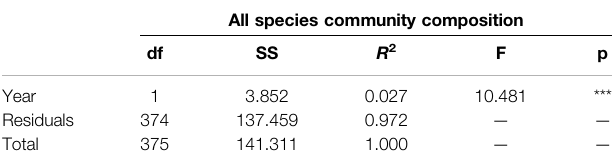
TABLE 2 | Results of permutational multivariate analysis of variance (PERMANOVA) using Bray – Curtis distance matrices, testing for the effect of year on community species composition from both 2008 and 2018. Asterisks denote signi fi cant differences at p < 0.01 (**), p < 0.001 (***). All species community